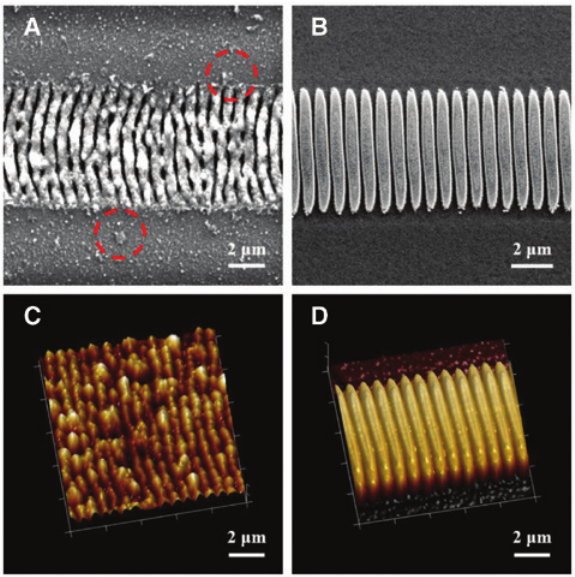
Figure 3: Homogeneity comparison of the fabricated structures. (A) SEM micrograph of the conventional LIPSSs fabricated by using = 1000 μ m s −1 and laser fluence laser scanning speed v scan F = 450 mJ cm −2 . (B) SEM micrograph of nanograting structures fabricated by chemical etching assisted femtosecond laser = 2000 μ m s −1 , laser fluence modification, using scanning speed v scan = 60 s. (C) and (D) AFM images F = 167 mJ cm −2 , and etching time T et show the details of the surface morphology of (A) and